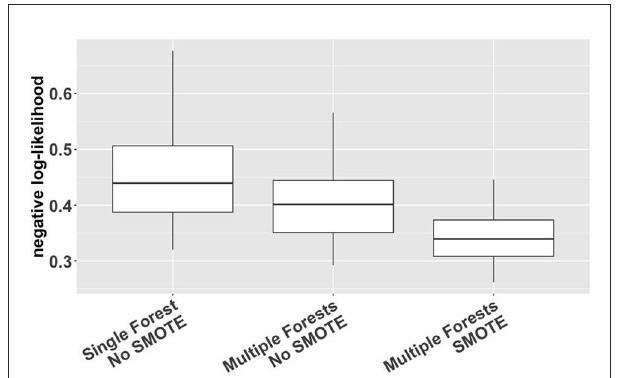
FIGURE2 Cross-validated negative log-likelihood for three different versions of VMM (single forest vs. multiple forests; with or without SMOTE) based on 1,000 replicates of five-fold cross-validation.